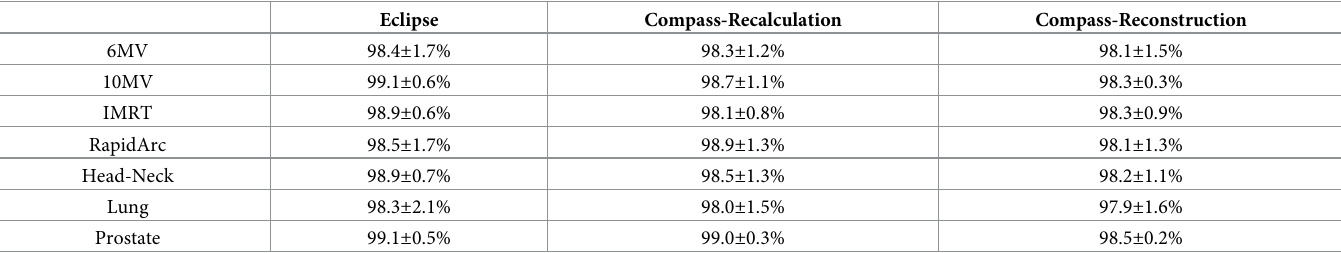
Table 2. Average pass rate calculated in a gamma evaluation between a measured dose using ArcCHECK and a predicted dose in each of the dose calculation tools. Eclipse Compass-Recalculation